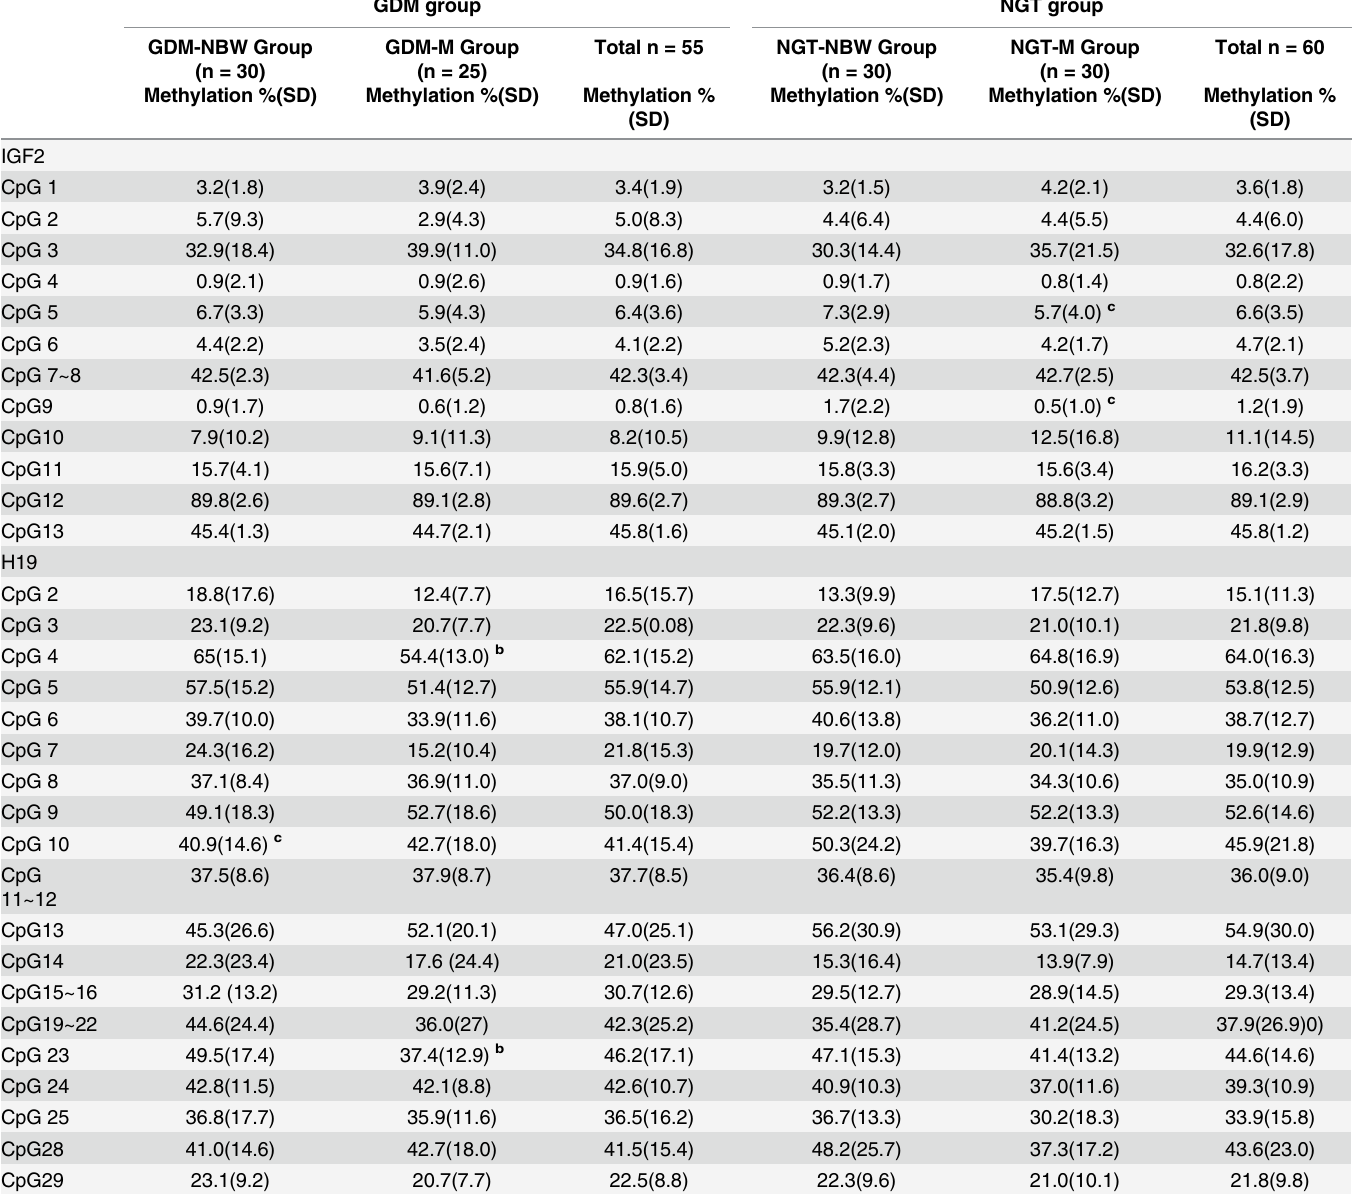
Table 3. Average Methylation Level of IGF2/H19 Gene in Umbilical Cord